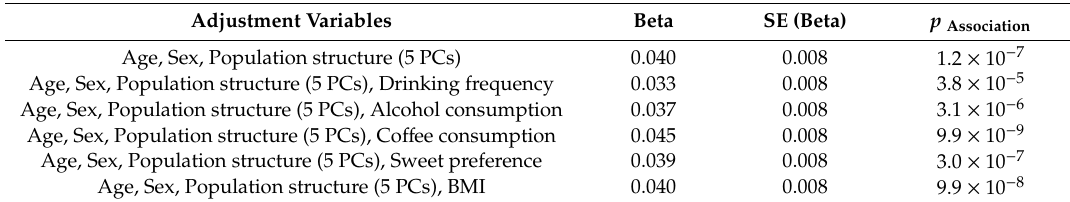
Table 3. Additional adjustment for confounding factors.